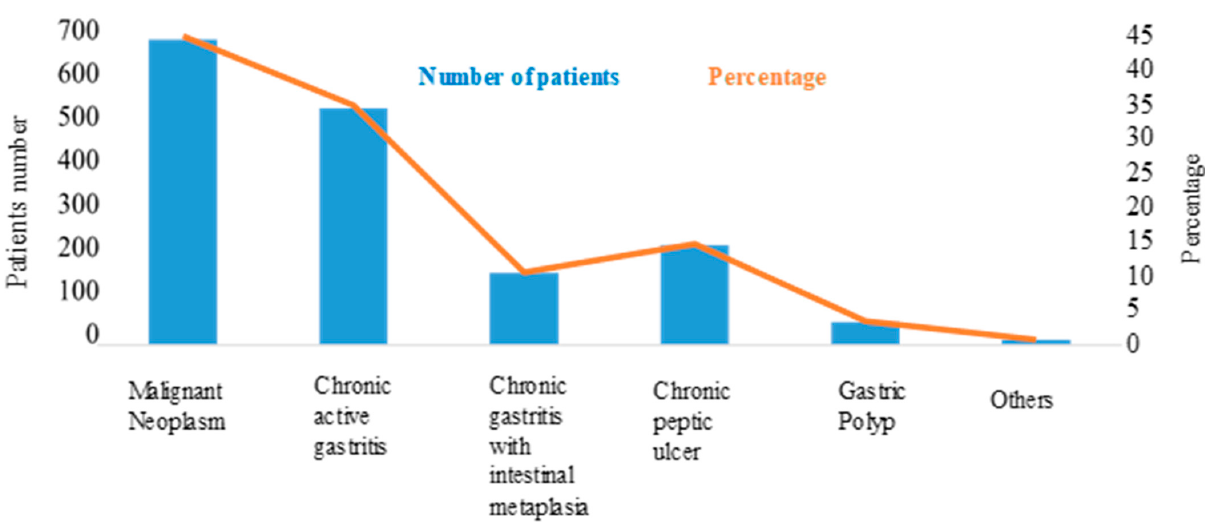
Figure 5. Incidence of different types of gastric carcinoma among Bangladeshi population. Chronic active gastritis was a major cause of gastric cancer, after malignant neoplasm. Untreated gastritis can lead to ulcers; thus, chronic peptic ulcers are in third position for gastric